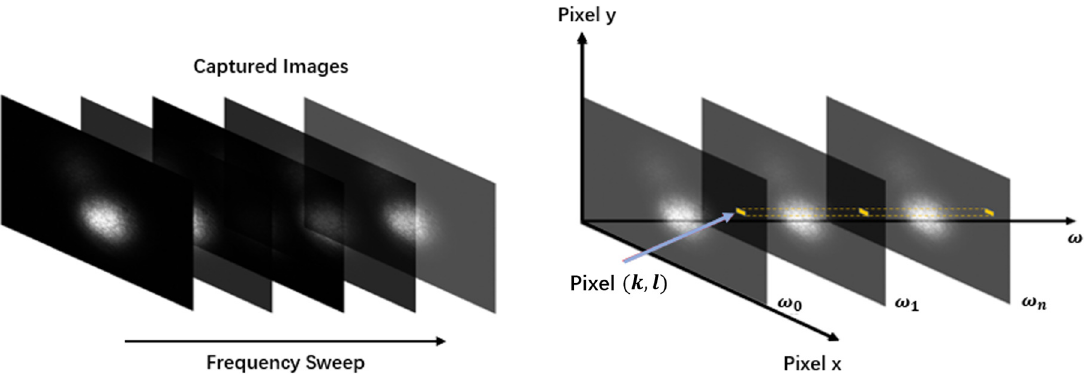
pixel values are collected. values are collected.